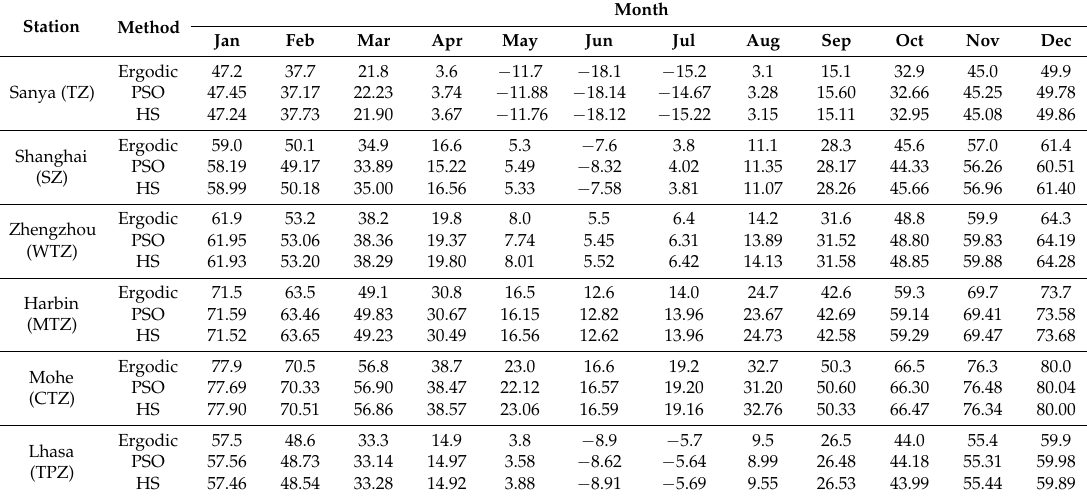
Table 2. Optimum tilt angles of each station obtained by ergodic, particle swarm optimization (PSO), and harmony search (HS) methods.